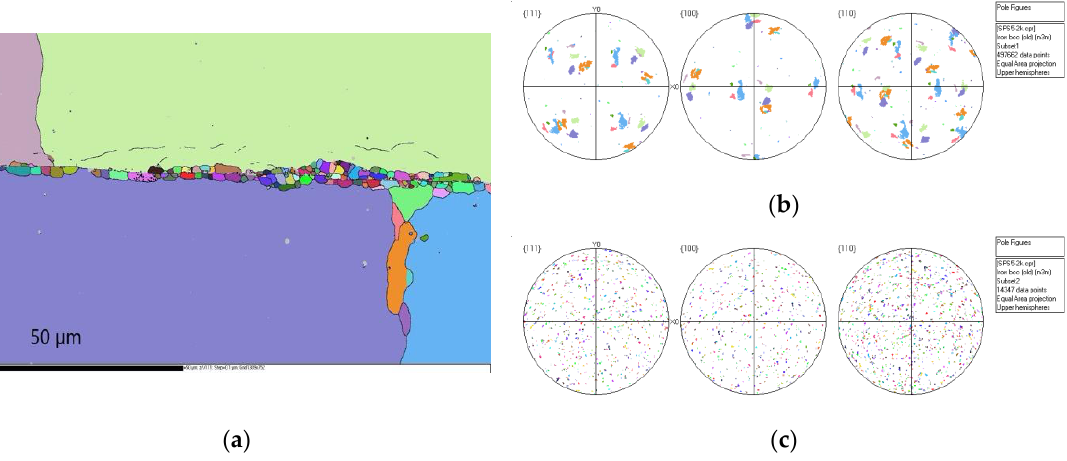
Figure 7. Scanning electron microscopy (SEM) image in backscattered electron (BSE) imaging of the interface between two joined disks with ground surfaces.